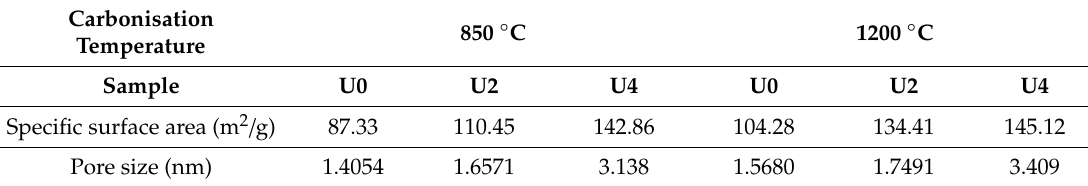
Figure 6. Isothermal adsorption/desorption of nitrogen in various CFs. Table 3. Brunauer, Emmett and Teller (BET) surface area and pore characteristics of the various